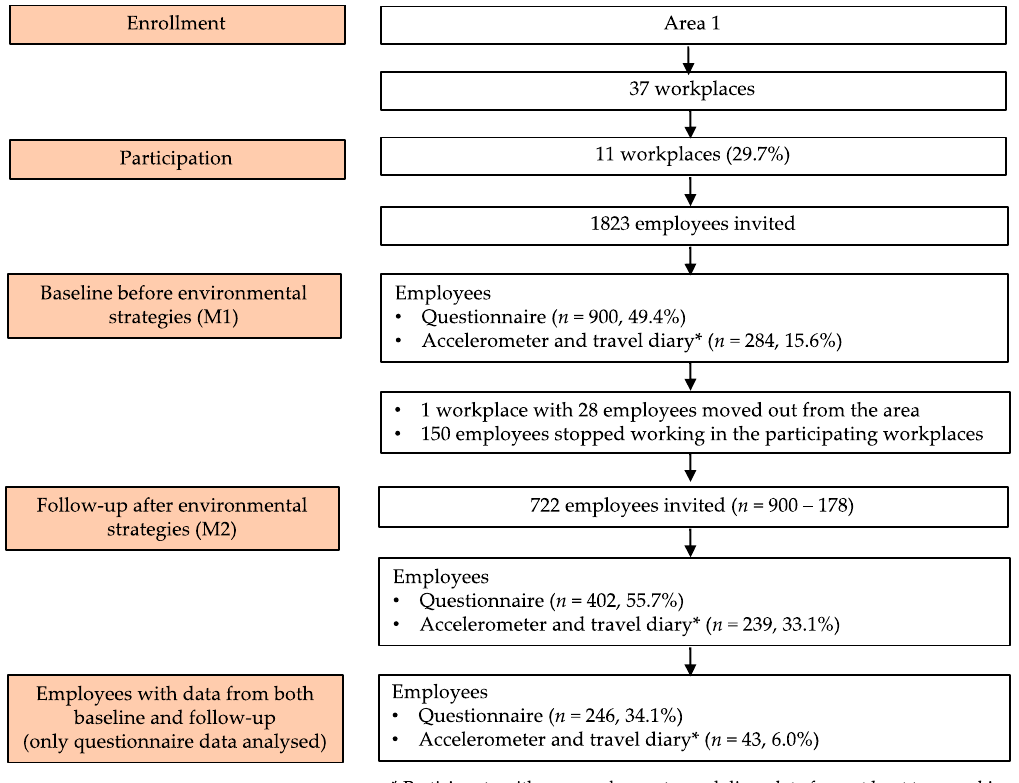
region. Table 2. Baseline characteristics of the participants in Phase 1 and Phase 2. EXP: experimental group; COM: comparison group. Baseline Characteristic